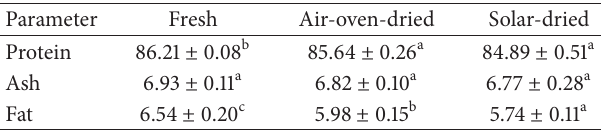
Means with different superscripts along the same row are significantly different ( 𝑝 < 0.05 ).